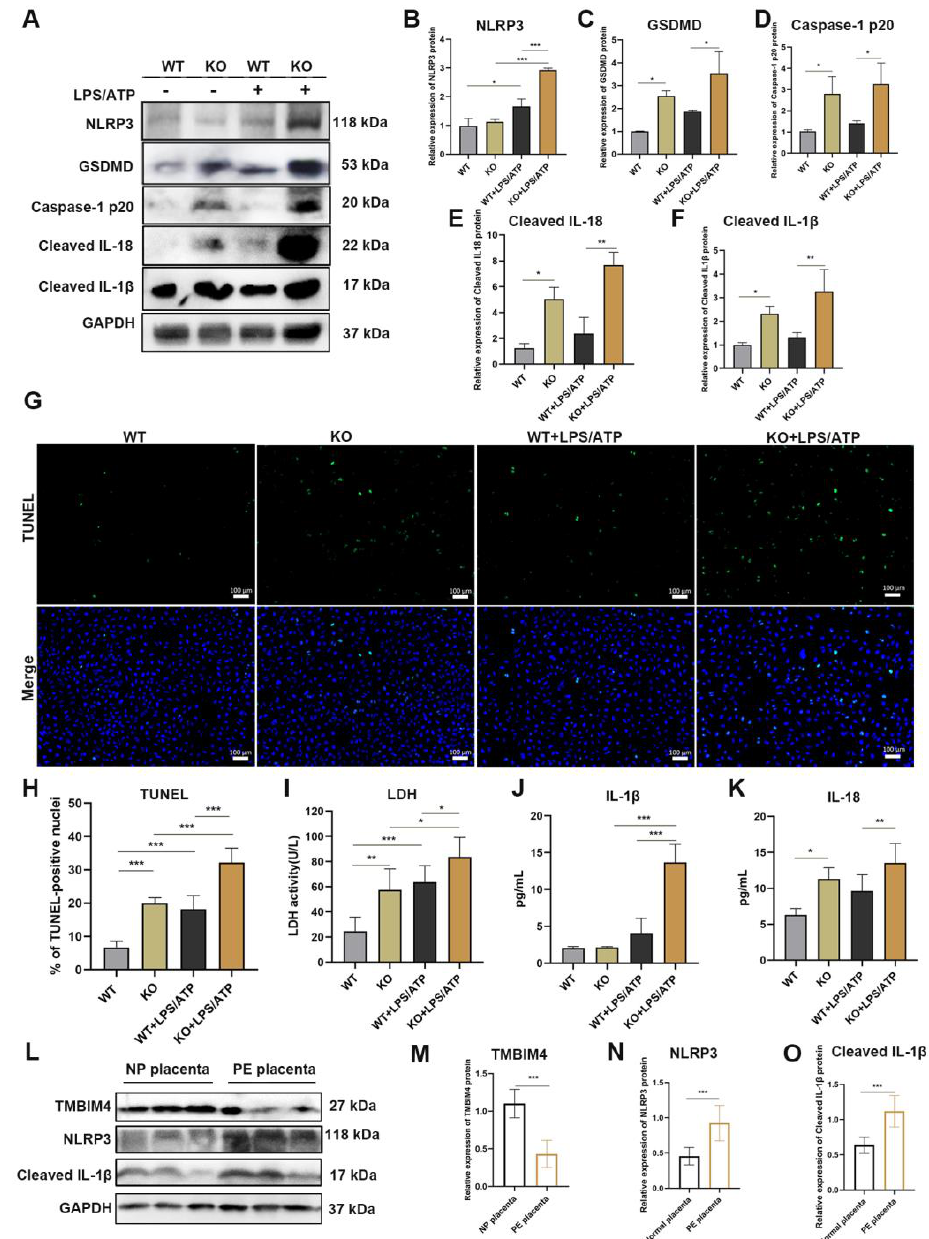
Figure 4. TMBIM4 deficiency enhances LPS-induced NLRP3 inflammasome activation and pyroptosis. ( A ) Immunoblot images of NLRP3, GSDMD, caspase-1 p20, cleaved IL-1 β , and cleaved IL-18. ( B – F ) Graphs showing the results of quantitative densitometry analysis of NLRP3 ( B ), GSDMD ( C ), caspase-1 p20 ( D ), cleaved IL-1 β ( E ), and cleaved IL-18 ( F ) levels in cell lysates. ( G , H ) Representative TUNEL assay images of WT, TMBIM4 KO, LPS/ATP-treated WT, and LPS/ATP-treated TMBIM4 KO HTR8/SVneo cells ( G ); the percentage of dead cells is presented in H. Dead cells are indicated by a green signal and the cell nuclei are indicated by a blue signal (DAPI stain). ( I ) Graphs showing the content of LDH leakage into the cell culture medium in four groups. Each assay was independently conducted at least 5 times. ( J , K ) Production of IL-18 and IL-1 β in the culture medium of the indicated cells based on ELISA. Each assay was independently conducted at least 5 times. ( L ) Immunoblot images of TMBIM4, NLRP3, and IL- 1β protein expression in placental samples from the NP and early-onset PE groups ( L ). ( M – O ) Quantitative analysis of the TMBIM4, NLRP3, and IL- 1β immunoblot bands relative to the control based on densitometry. All quantitative data are presented as mean ± SD. * p < 0.05, ** p < 0.01, *** p < 0.001. Bar = 100 μm.